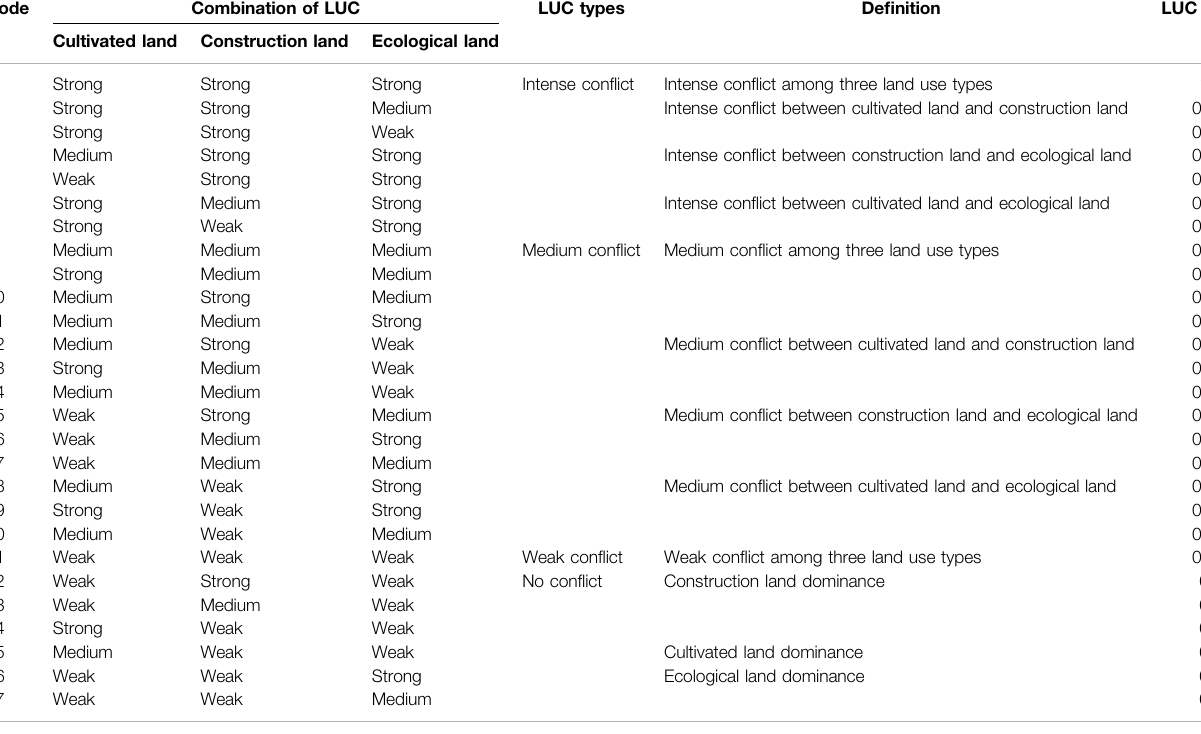
TABLE 2 | Types of land con fl ict types and de fi nition based on all combinations of three con fl ict ranks and three land use types.